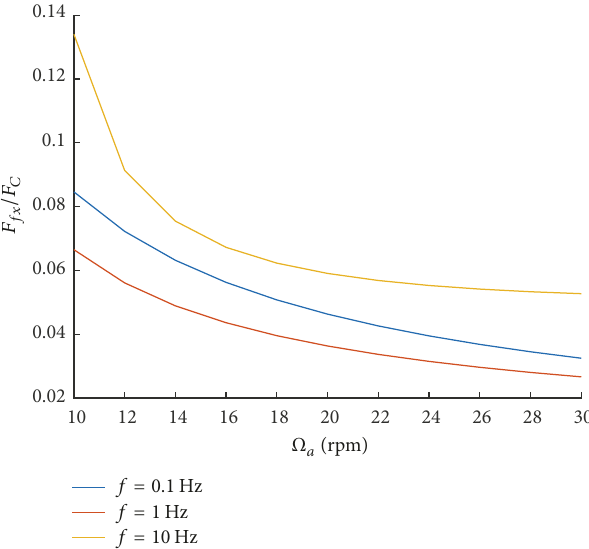
Figure13:Influenceoffrequencyoftorsionaloscillationontheaxial friction due to bristle deformation.